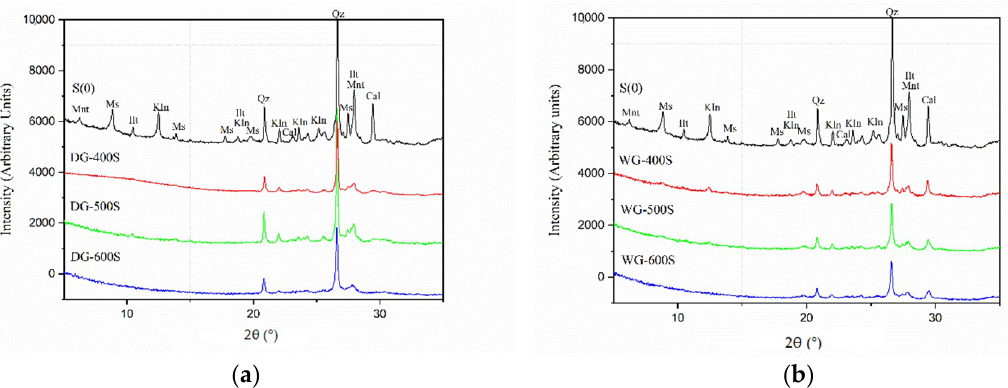
Figure 9. XRD diffraction patterns for different speeds during grinding of a Swedish raw clay: ( a ) dry grinding for sample S0, DG-400S, DG-500S, and DG-600S; and ( b ) wet grinding for sample S0, WG-400S, 500 rpm WG-500S, and WG-600S. [Kln-kaolinite, Mnt-Montmorillonite, Ms-muscovite, Ilt-illite, Qz-quartz, Cal-calcite].